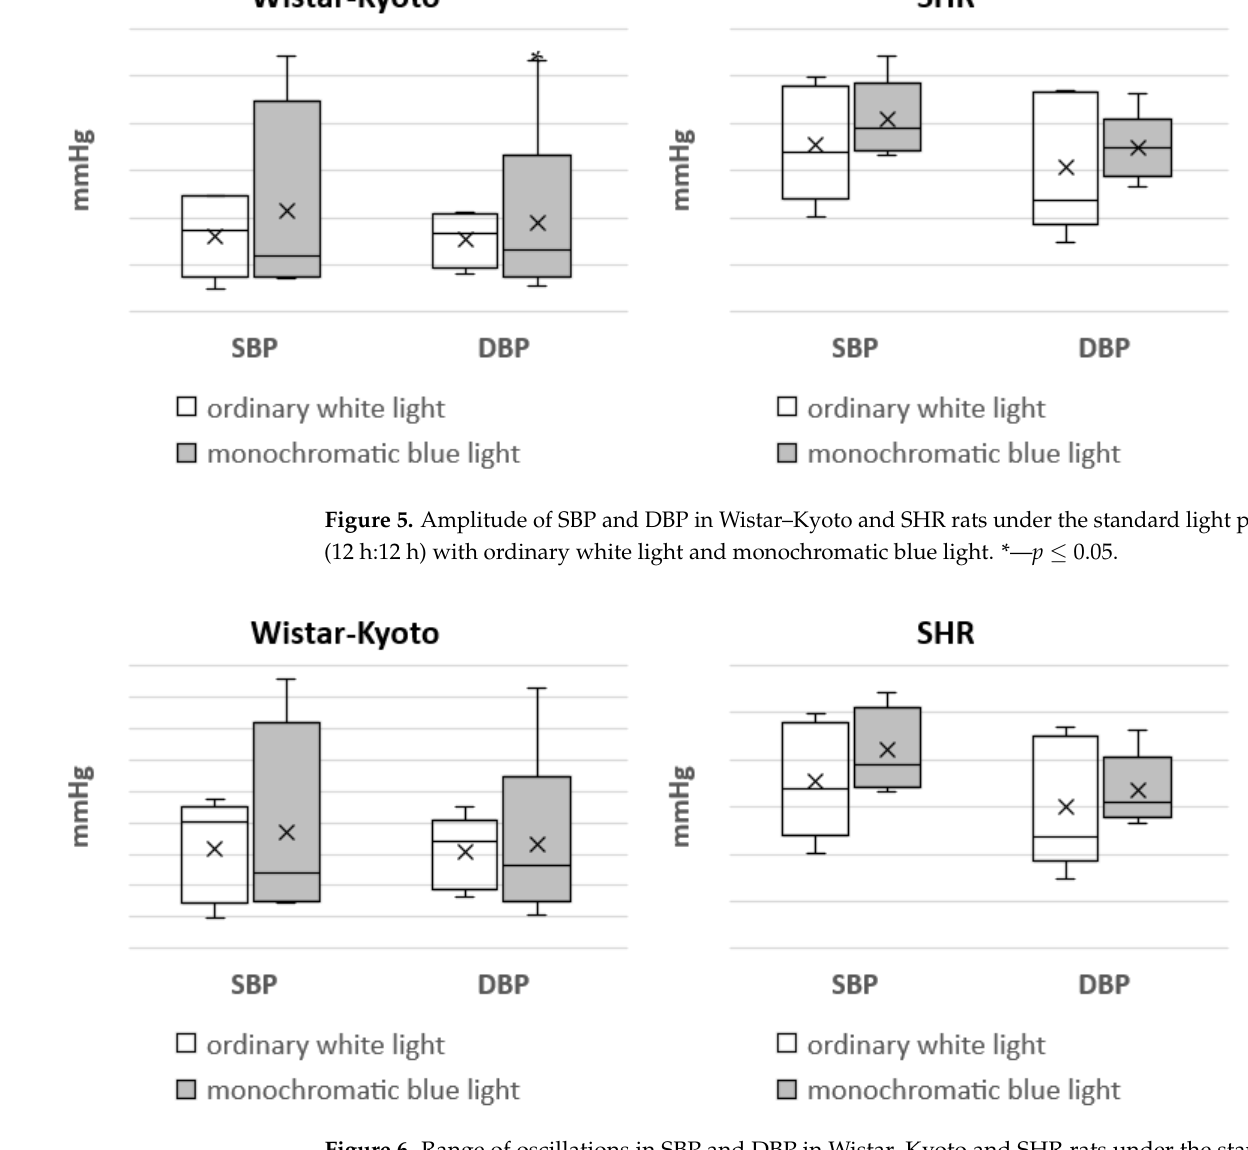
Figure 6. Range of oscillations in SBP and DBP in Wistar–Kyoto and SHR rats under the standard light pattern (12 h:12 h) with ordinary white light and monochromatic blue light.